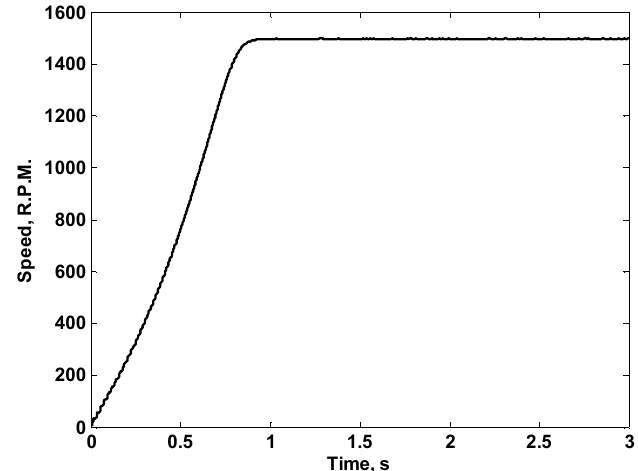
Figure 28. Three-Phase Motor Speed during Two-Battery Failure.